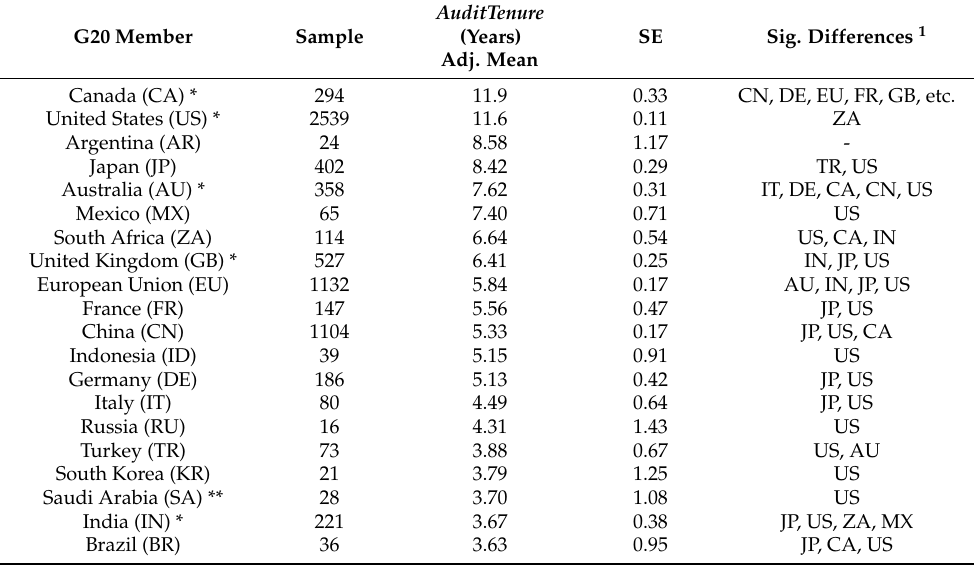
Table 8. The analysis of covariance of AuditTenure by country/group of countries, adjusted for company size, in descending